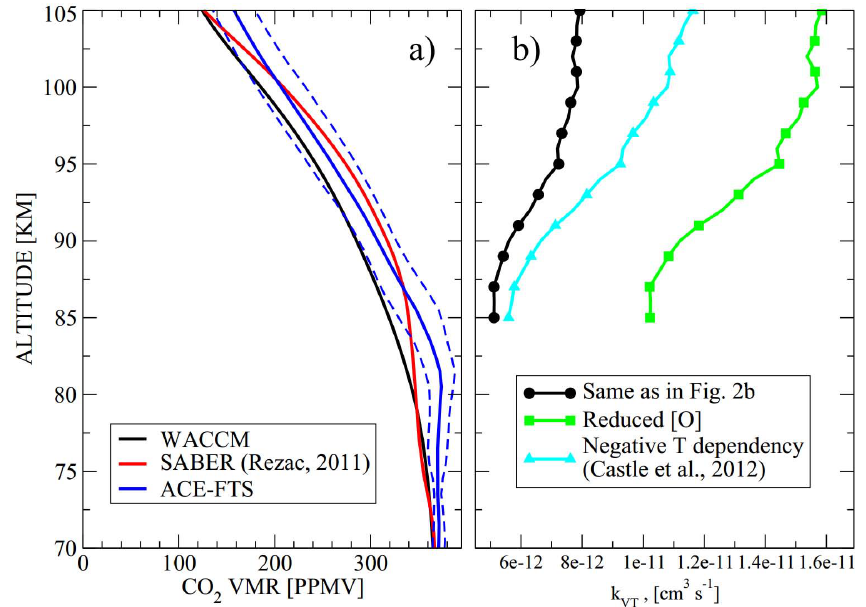
Fig. 3. (a) Average vertical distributions of CO 2 VMR distributions for 40.6±2 ◦ N in 2002–2009 for WACCM and SABER, and in 2008– 2009 for ACE-FTS. Dashed blue lines denote standard deviation for the ACE-FTS CO 2 profile; (b) estimated vertical profile of k VT (z) for O (z) divided by 2 and for a negative temperature dependency of k VT according to the latest laboratory measurements (Castle et al., 2012).